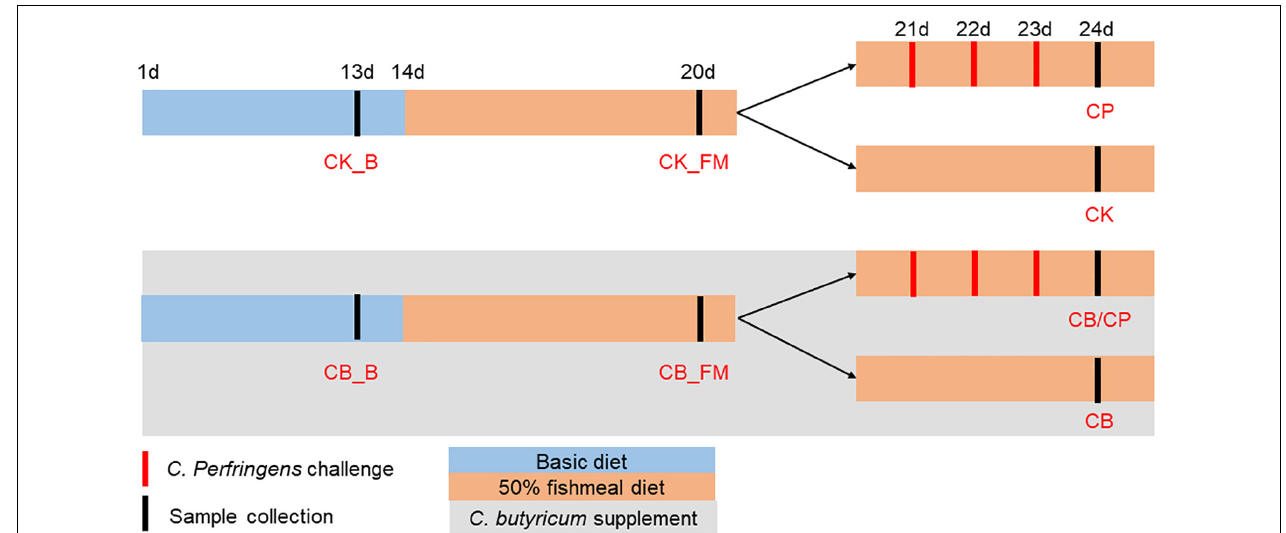
FIGURE 1 | Experimental design. CB_B ( n = 60): C. butyricum supplemented chickens on a basal diet; CK_B ( n = 60): C. butyricum non-supplemented chickens on a basal diet; CB_FM ( n = 48): C. butyricum supplemented chickens on a high-fishmeal diet; CK_FM ( n = 48): C. butyricum non-supplemented chickens on a high-fishmeal diet; CB/CP ( n = 18): C. perfringens- challenged chickens with C. butyricum supplementation; CB ( n = 18): C. perfringens- unchallenged chickens with C. butyricum supplementation; CP ( n = 18): C. perfringens -challenged chickens without C. butyricum supplementation; CK ( n = 18): C. perfringens -unchallenged chickens without C. butyricum